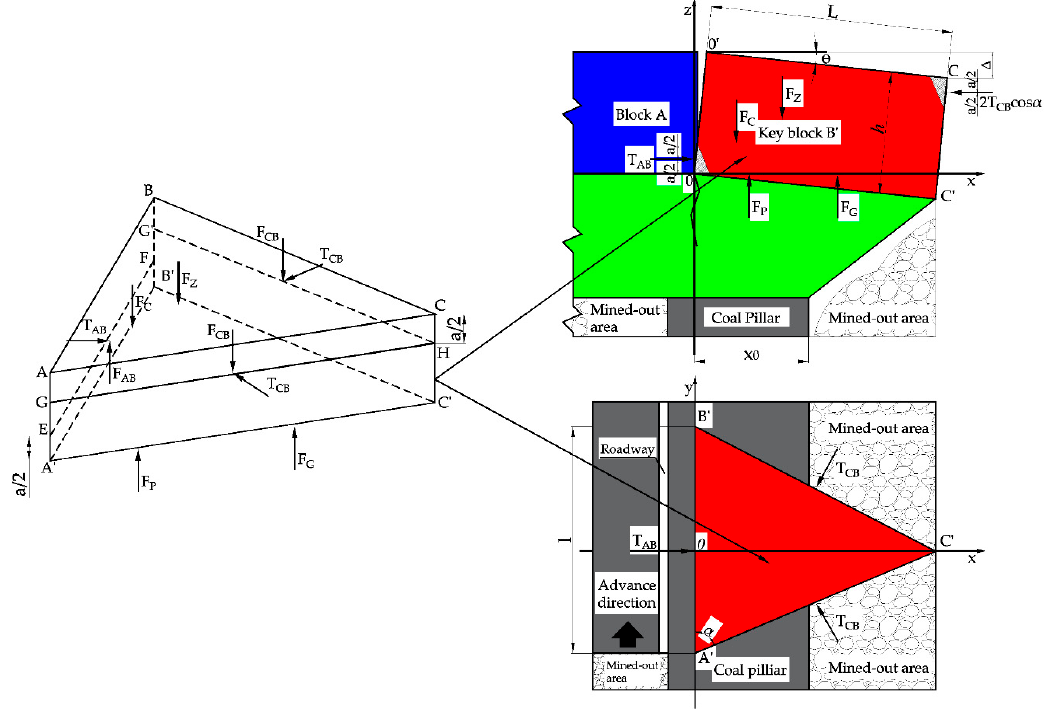
Figure 7. The key block B’ mechanical model.